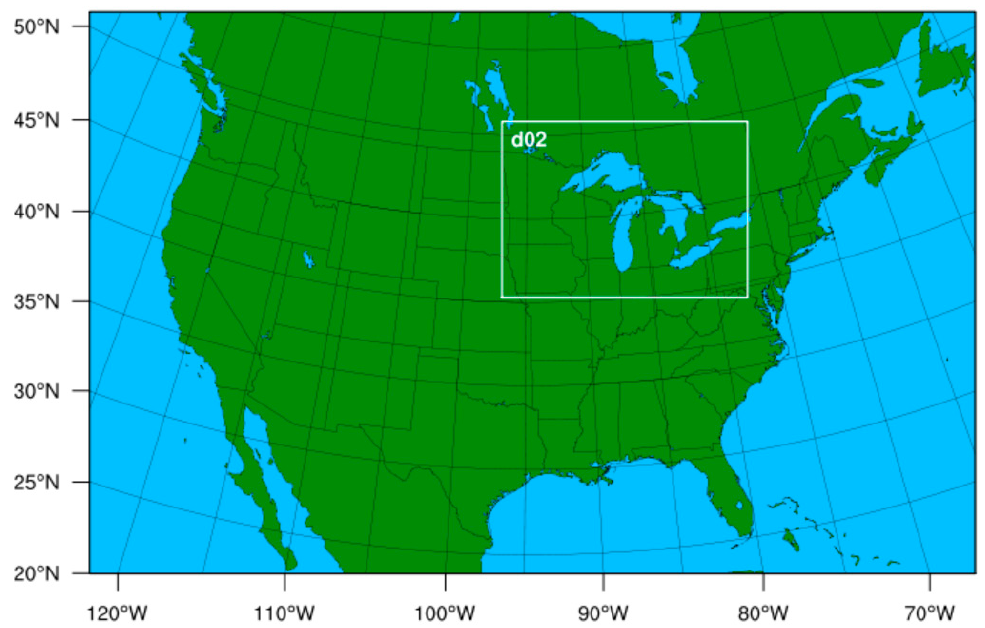
Figure 6. Domain configuration for the WRF-ARW simulations. Spatial resolutions for the parent domain and the nested domain (d02) were 12 and 4 km, respectively. Table 5. WRF-ARW parameterizations used for this study (same as [27]).